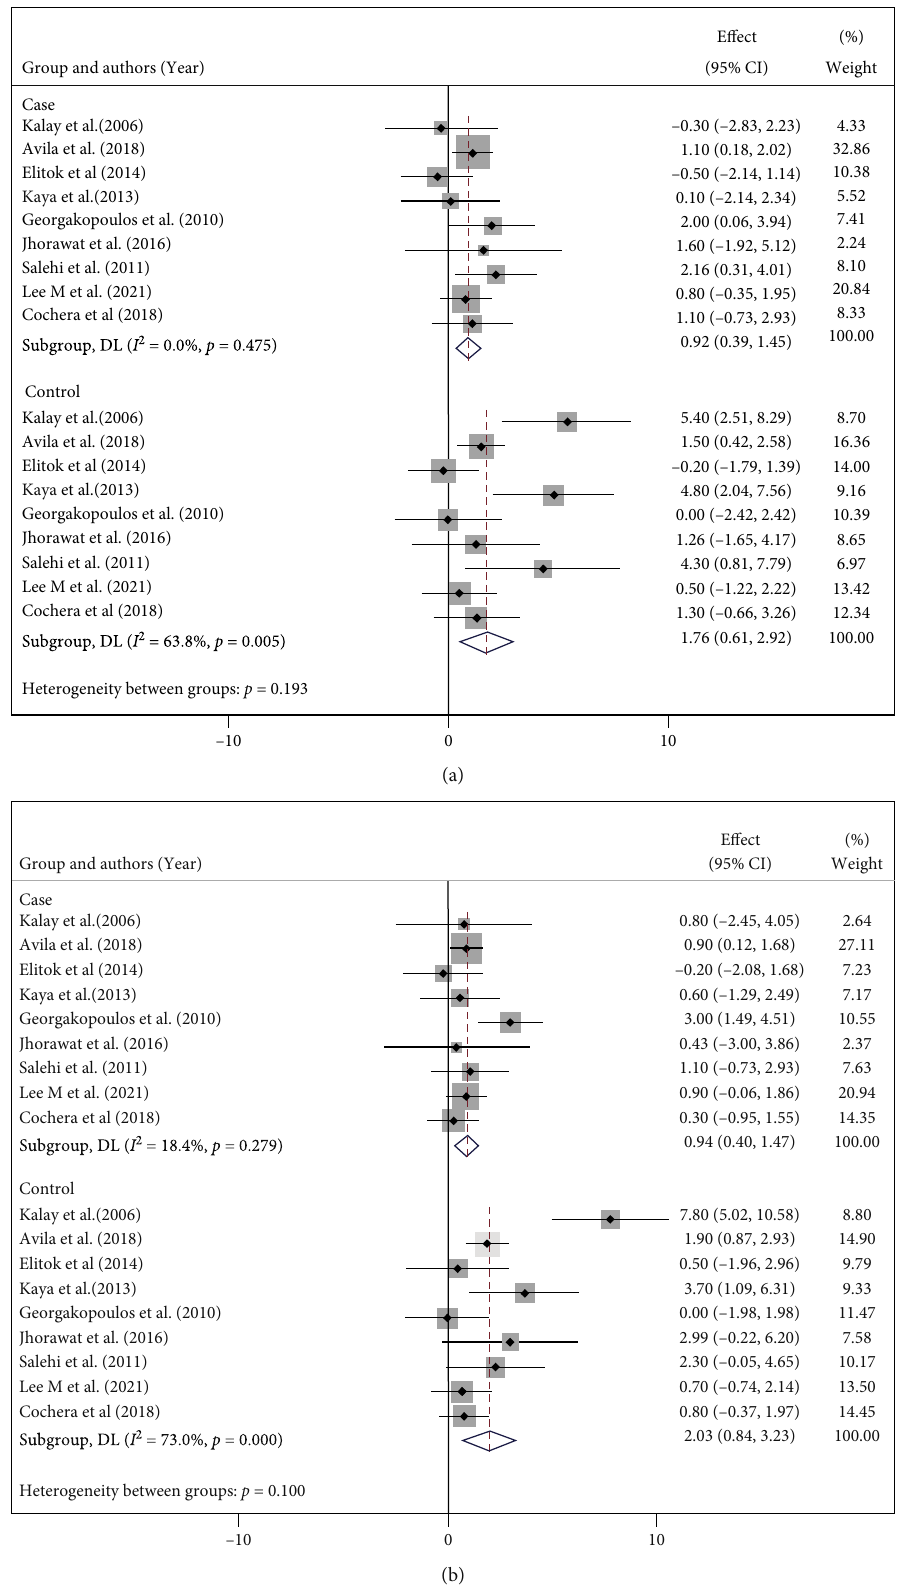
Figure 5: Forestplot of two group changes from the baseline in (a) Left ventricular end-diastolic diameter (LVEDD) and (b) Left ventricular end-systolic diameter (LVESD)